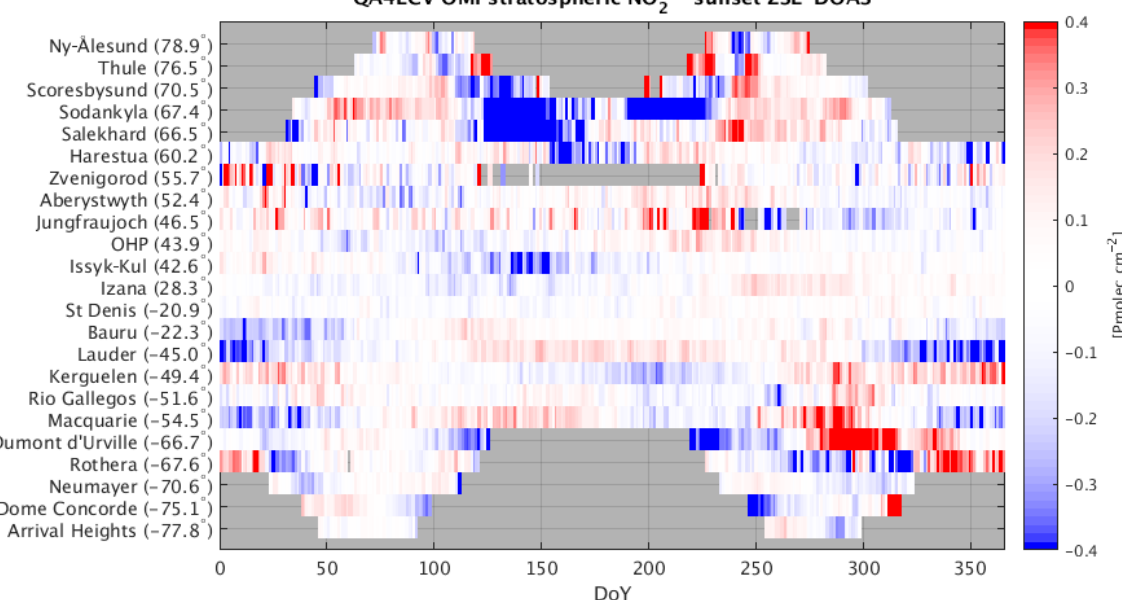
Figure 6. Median difference for each station (ordered by latitude) and for each day of the year, taken over the entire 14-year record, between QA4ECV OMI stratospheric NO 2 and the co-located, photochemically adjusted, sunset ZSL-DOAS